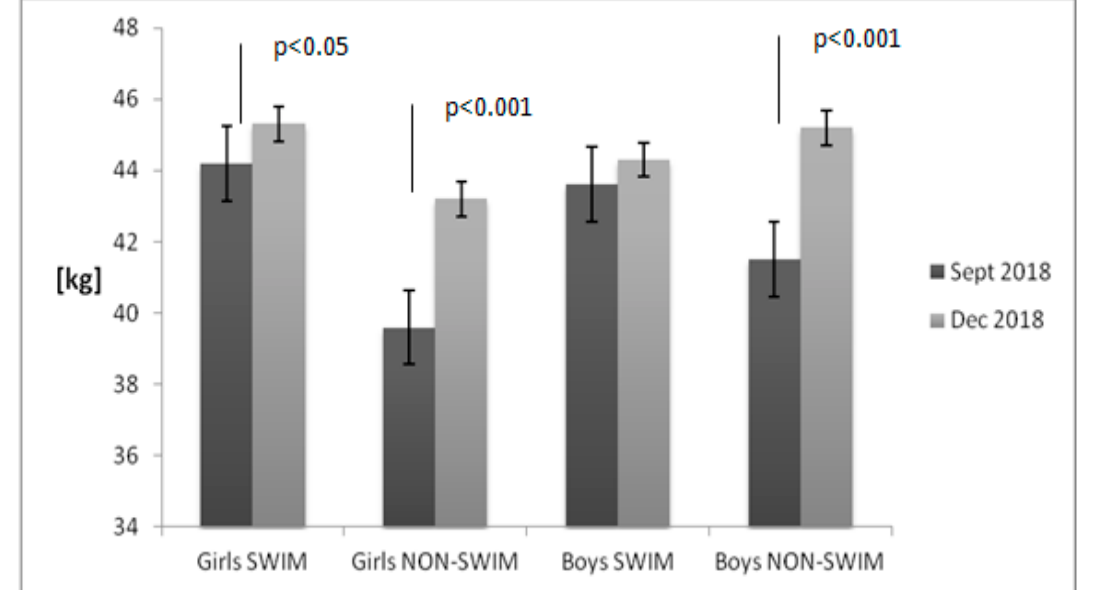
Figure 2. Body mass changes in the examined groups of children. Data are presented as mean value and standard error. The non-swimmers group consisted of children participating in team sports (soccer, basketball), athletics, martial arts and dance.